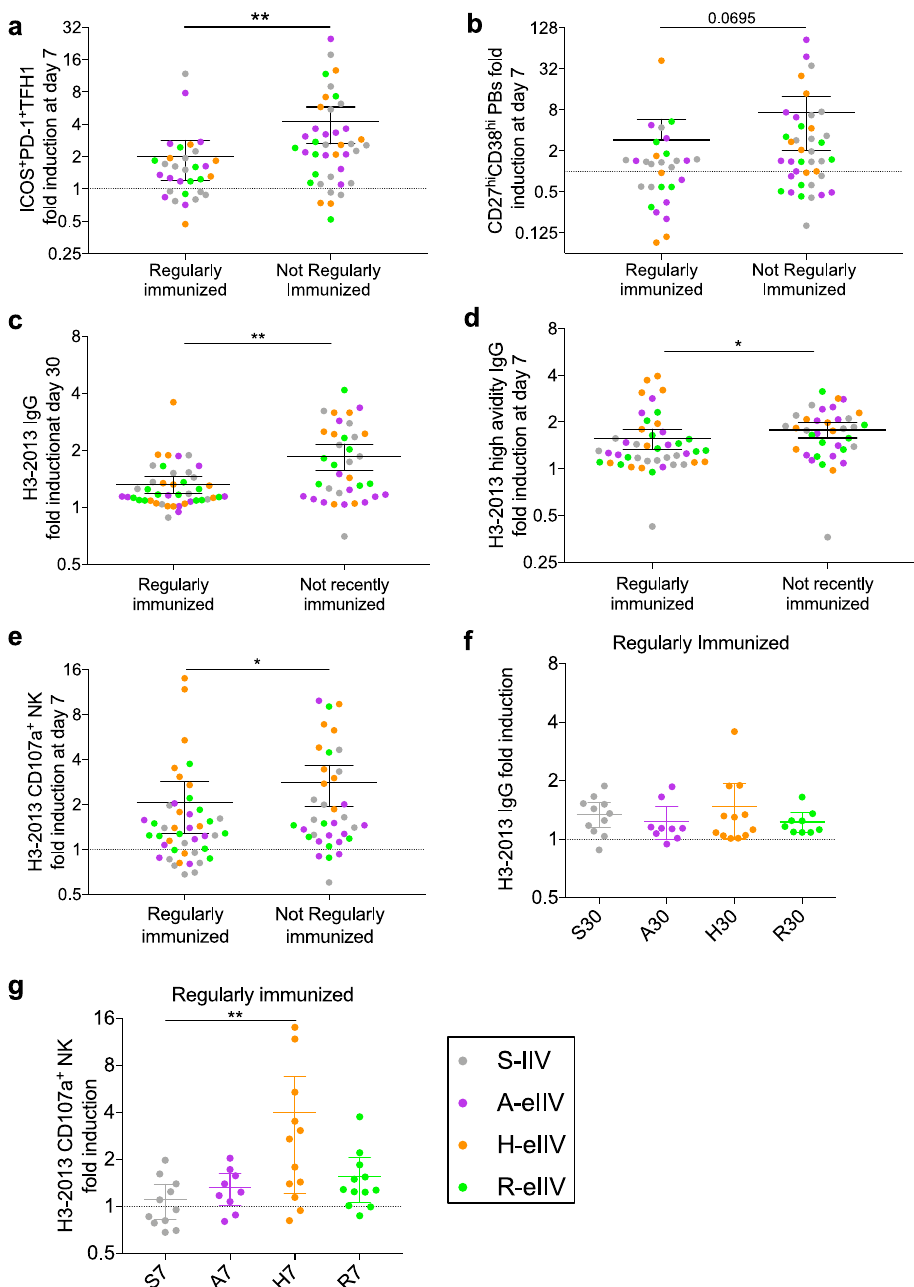
Fig. 5 Vaccine responses are restricted by prior vaccination. Subjects were separated by those regularly ( ≥ 3 vaccinations) and not regularly immunized (<2 vaccinations) in the past 5 years and the fold induction of a TFH1 cells and b plasmablasts (S, n = 24; A, n = 20; H, n = 13; R, n = 15), c H3-2013 HA - speci fi c IgG, d high-avidity IgG, and e CD107a + CD56 + NK cells ( n = 20 per vaccine group) was determined in pooled datasets, signi fi cance by Mann – Whitney t test. Fold induction of f day 30 H3 - 2013 HA-speci fi c IgG, g day 7 NK cell activation amongst